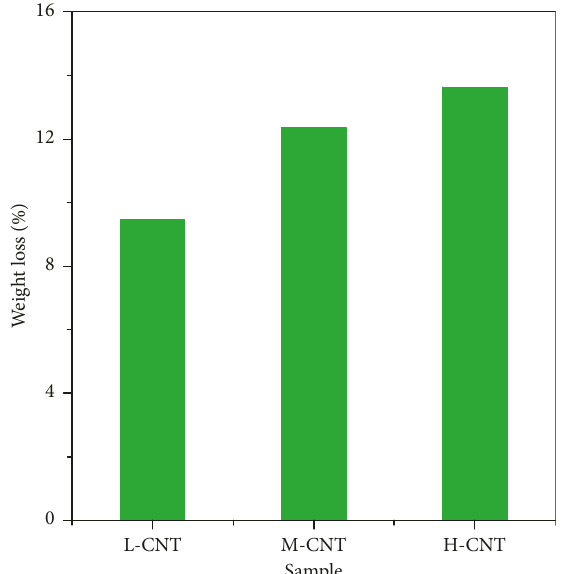
Figure 6: Weight loss of the modified CNTs under N